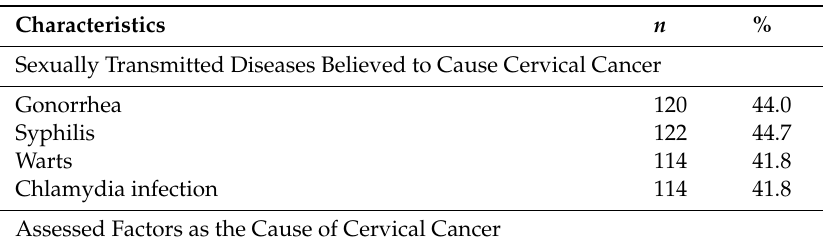
Table 4. Knowledge of cervical cancer.